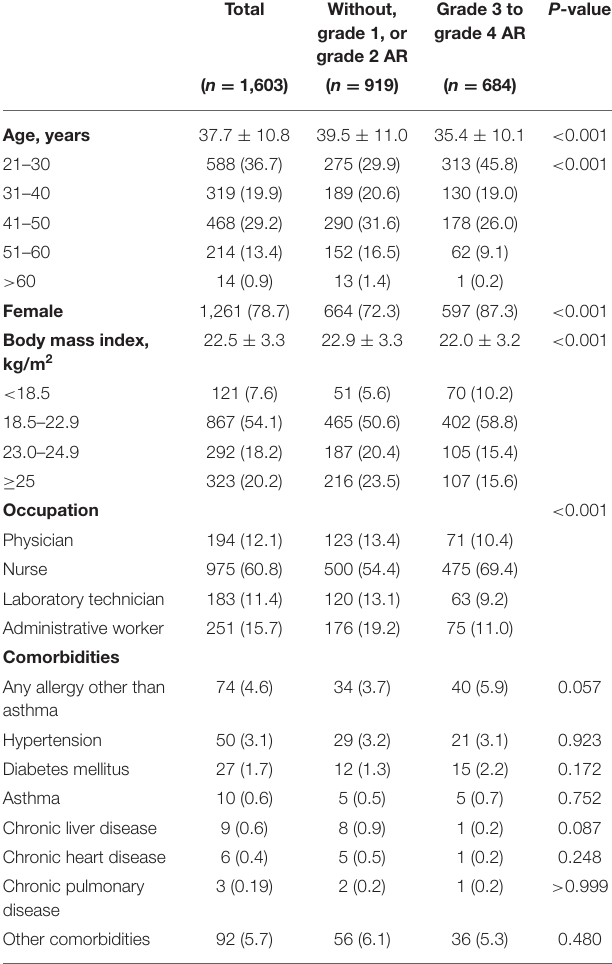
TABLE 1 | Baseline characteristics of the study